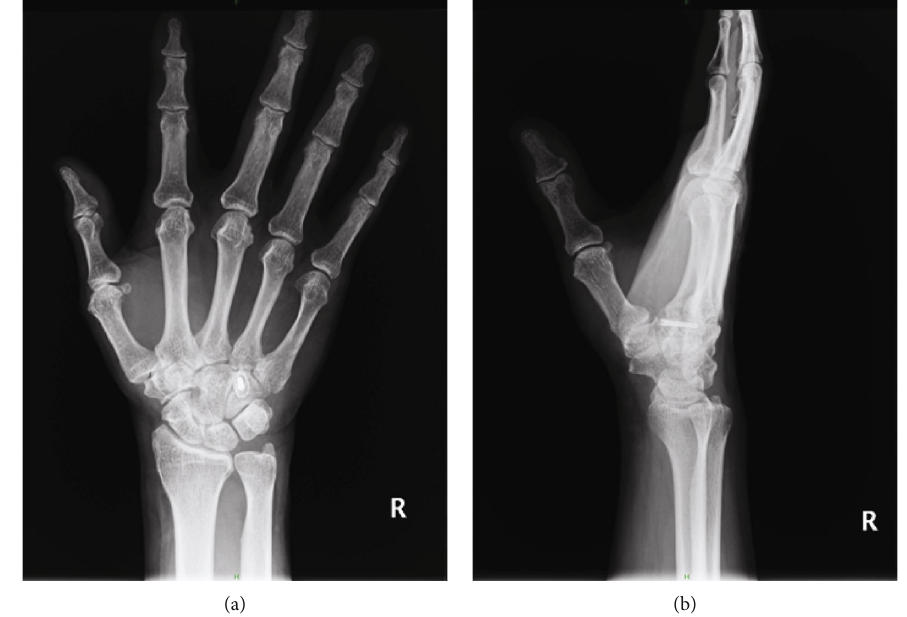
Figure 9: Radiograph 2 years after the surgery. (a) Posteroanterior view. (b) Oblique semisupinated view.